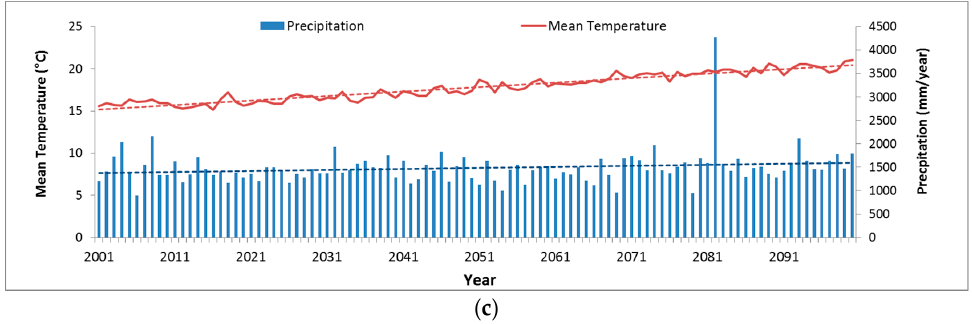
Figure 2. Annual precipitation & temperature by RCP 8.5 scenario: ( a ) Seoul; ( b ) Daegu; ( c ) Jeju.